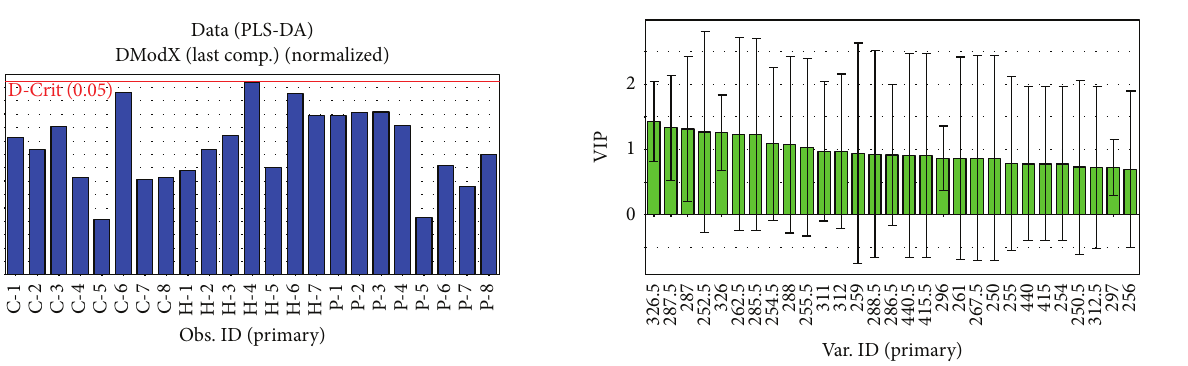
Figure 7: Variable importance for the projection (VIP) plot of absorbance for the contribution to sample separation from PLS-DA.